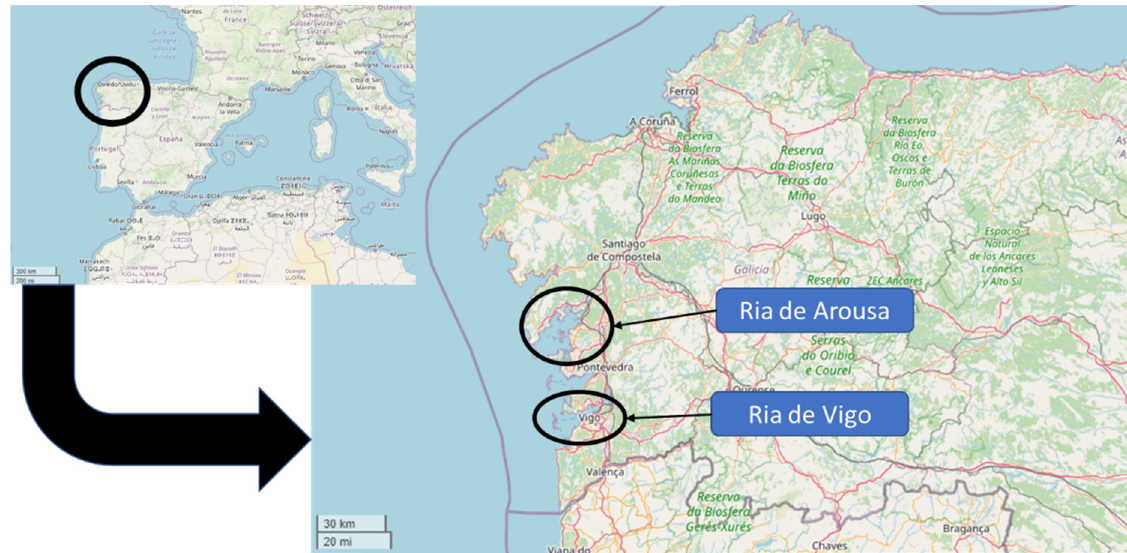
Figure 1. Geographical area for mussel sample collection.